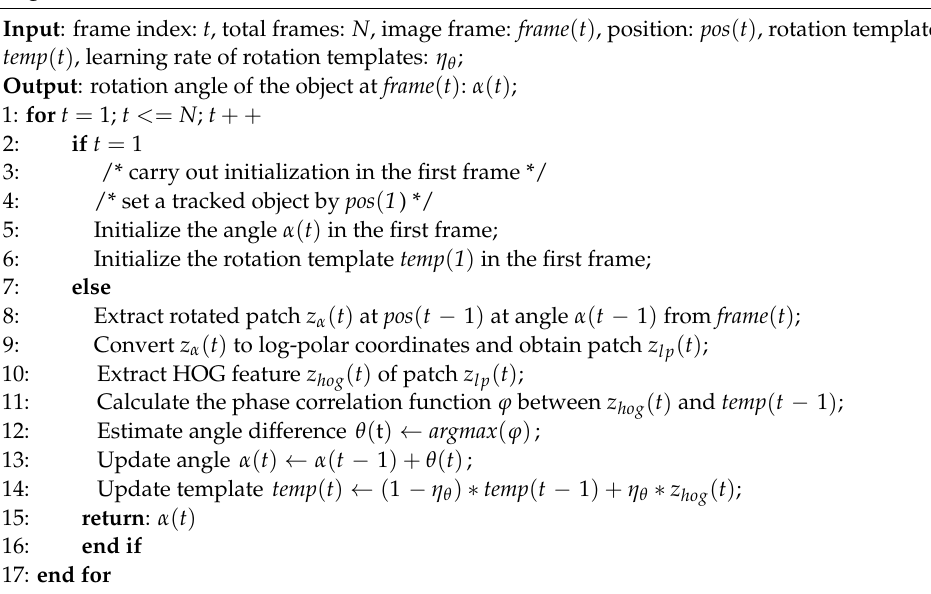
Algorithm 1 Rotation Branch